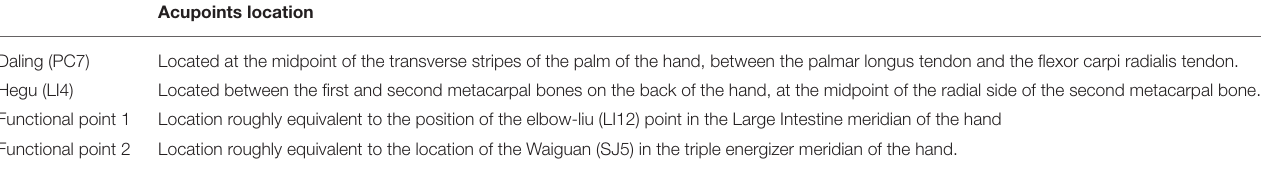
TABLE 2 | Location of acupoints for treating post-stroke upper limb spasticity. Acupoints